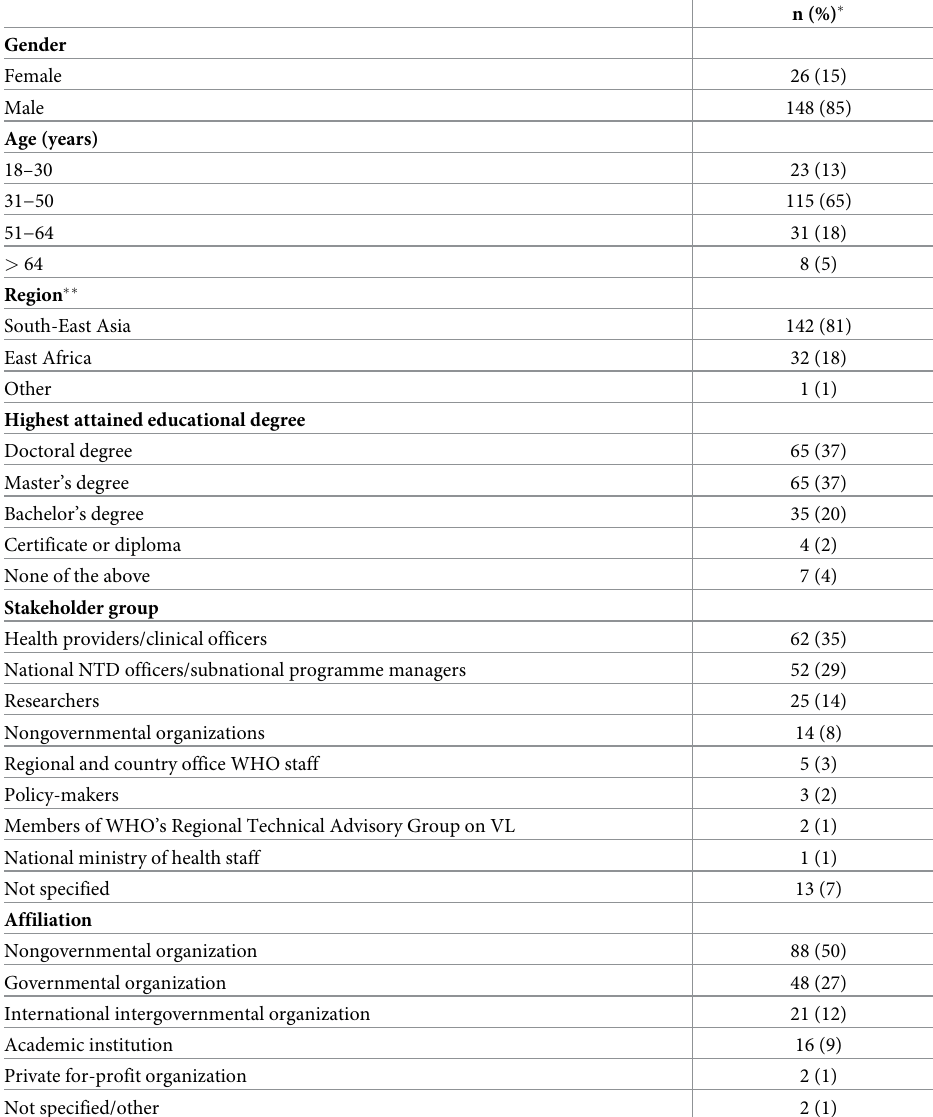
Table 1. Survey participants’ characteristics (N = 177).